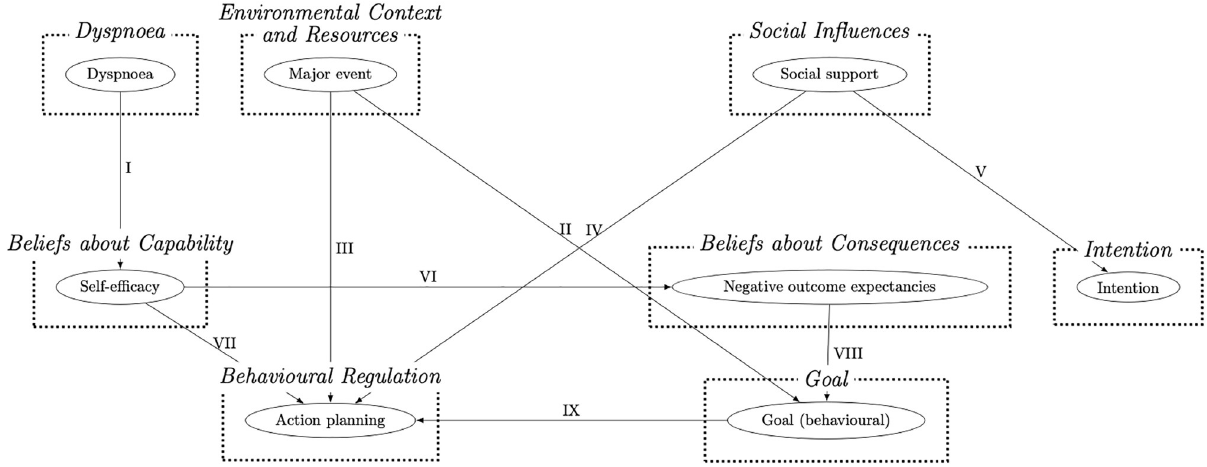
Fig 2. The graph summarising causal links as supported by the lexico-syntactic patterns analysis.